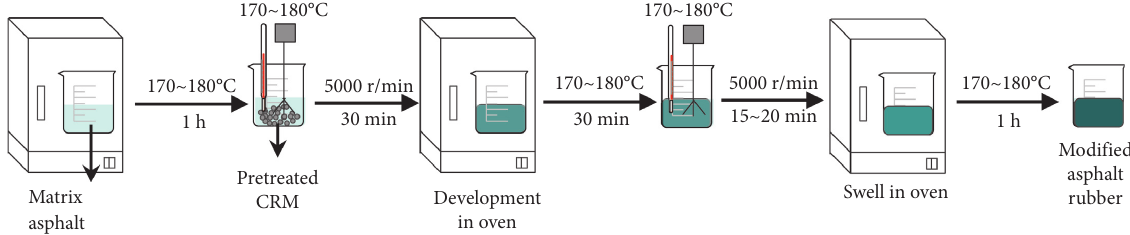
Figure 2: The process of preparing the modified asphalt